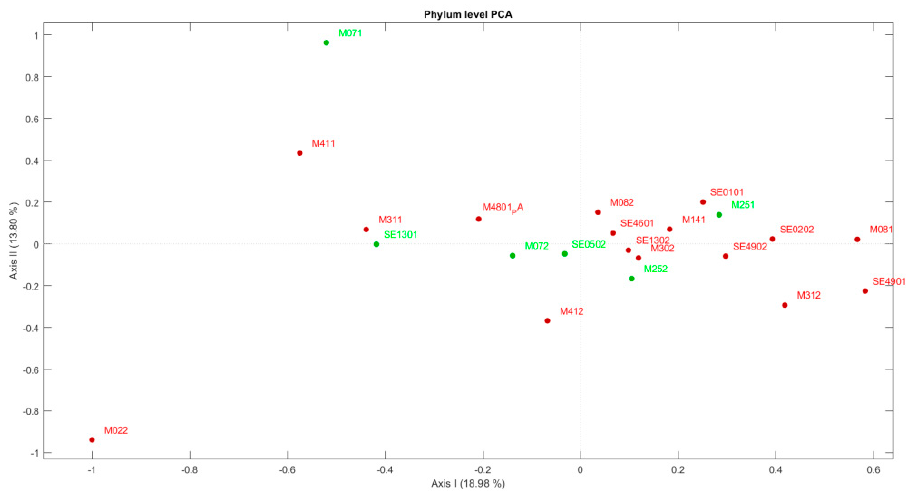
Figure 9. The results of PCA at the phylum level. Green: OSA − atherosclerosis. Red: OSA + atherosclerosis.